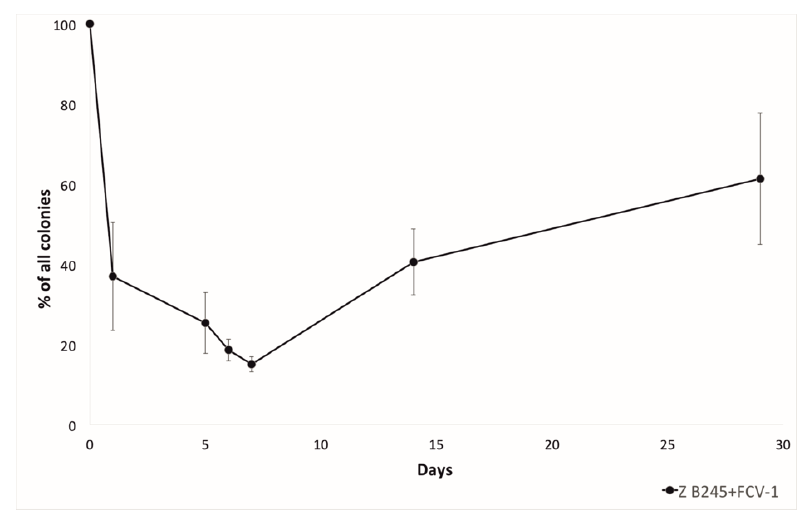
Figure 2. The proportion (percentage) of rhizoid (Z) colony types out of all of the colonies (rhizoid and rough) during the lake water experiment from the coculture of F. columnare strain B245 and phage FCV-1. In the treatments without phage, rough colonies were seen only on the last day (29) of